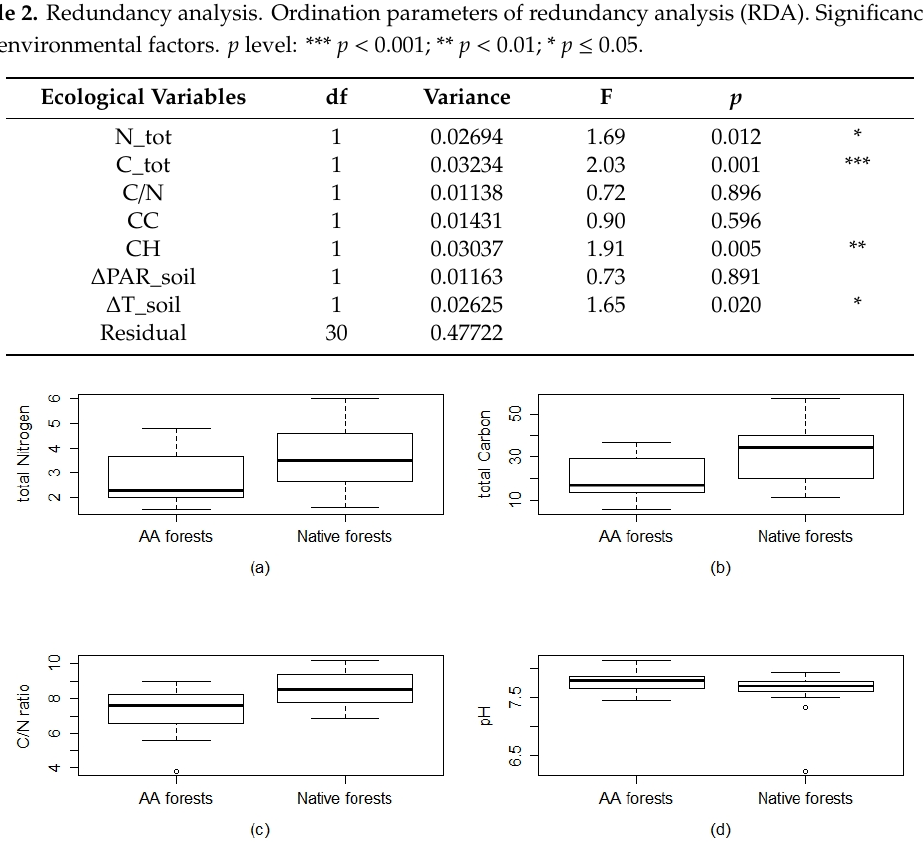
Figure 4. RDA Ordination diagram of vegetation plots and species in relation to the considered environmental variables. A. altissima forests are within the dashed line. Native forests are within the continuous line. Significant variables (at p value ≤ 0.05) are reported with asterisks. RDA1 explains 39.1% of the cumulative amount of variance expressed as proportions of the total explained variance and RDA2 axes as 19.02%. For abbreviations of the variables, see Table 3. Table 2. Redundancy analysis . Ordination parameters of redundancy analysis (RDA). Significance of Table 2. Redundancy analysis. Ordination parameters of redundancy analysis (RDA). Significance of the environmental factors. p level: *** p < 0.001; ** p < 0.01; * p ≤ 0.05.